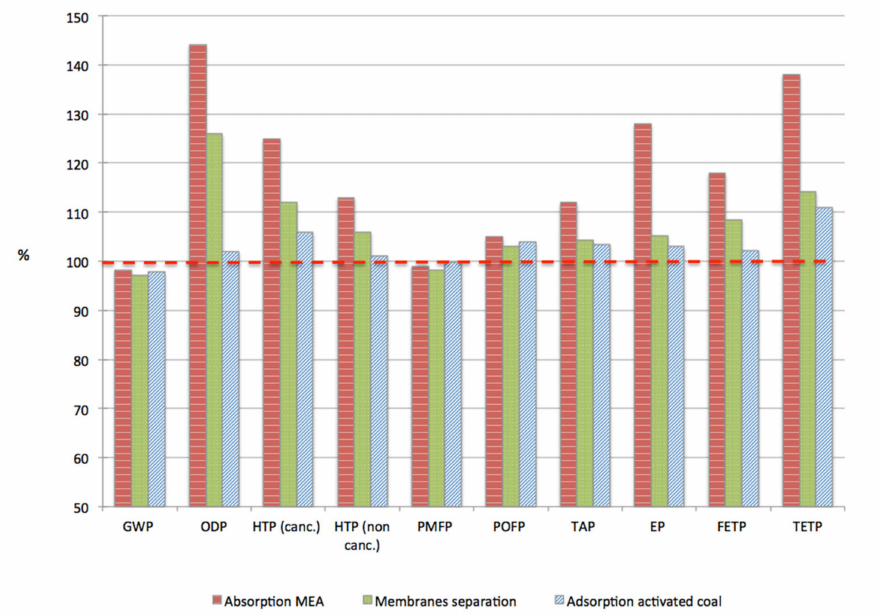
Figure 3. Comparison between the different CC scenarios and the reference case (set to 100%) for the following impacts: global warming potential (GWP100), eutrophication potential (EP), freshwater eutrophication (FEP), terrestrial acidification (TAP), particulate matter formation potential (PMFP), photochemical oxidant formation potential (POFP), ozone depletion potential (ODP), human toxicity potential (HTP), freshwater ecotoxicity potential (FETP), terrestrial eco-toxicity potential